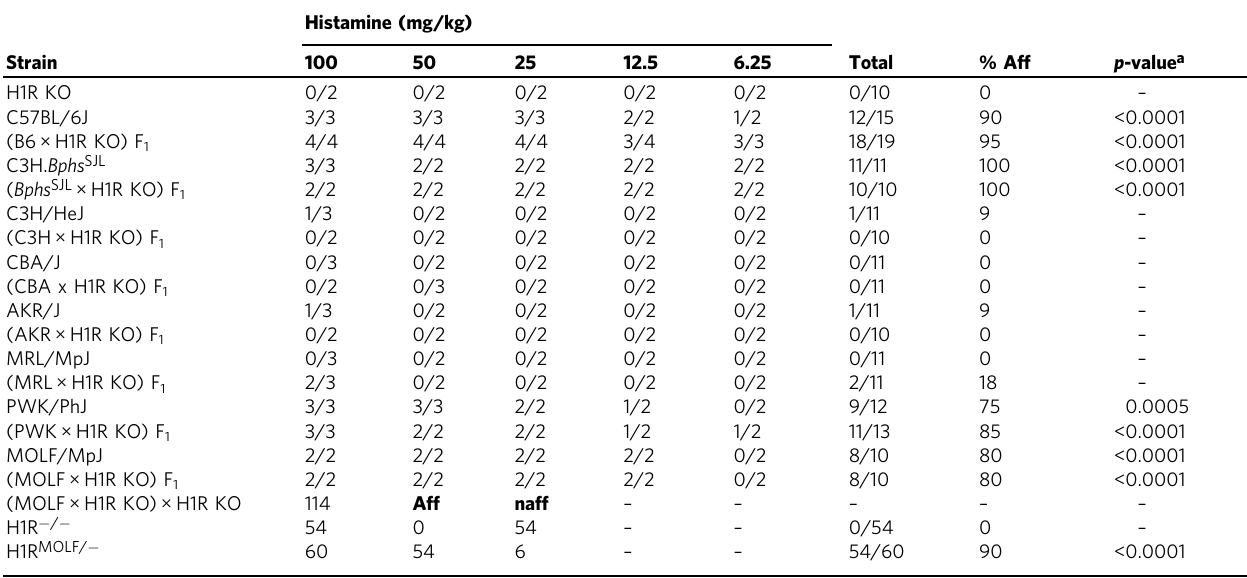
Table 3 Bphs susceptibility of Hrh1 s and Hrh1 r by H1R KO F 1 hybrid mice.